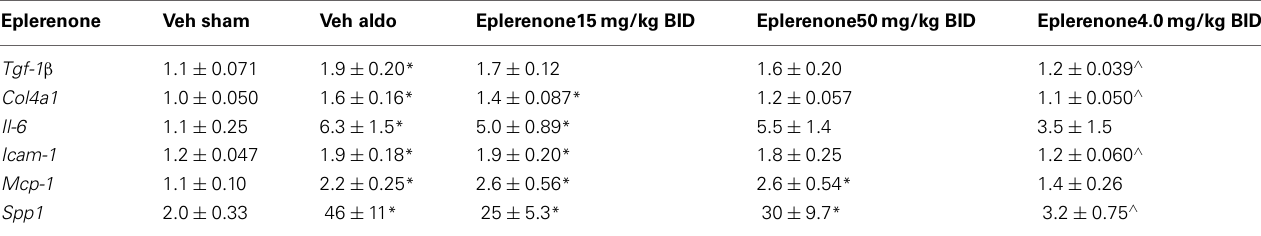
Values are mean realtive quantitation ± standard error of the mean, n = 10–11/group. One-way ANOVA with Tukey’s post-hoc analysis was performed. * Significantly different from vehicle sham (Veh sham); ∧ Significantly different from vehicle + aldosterone (Veh aldo).